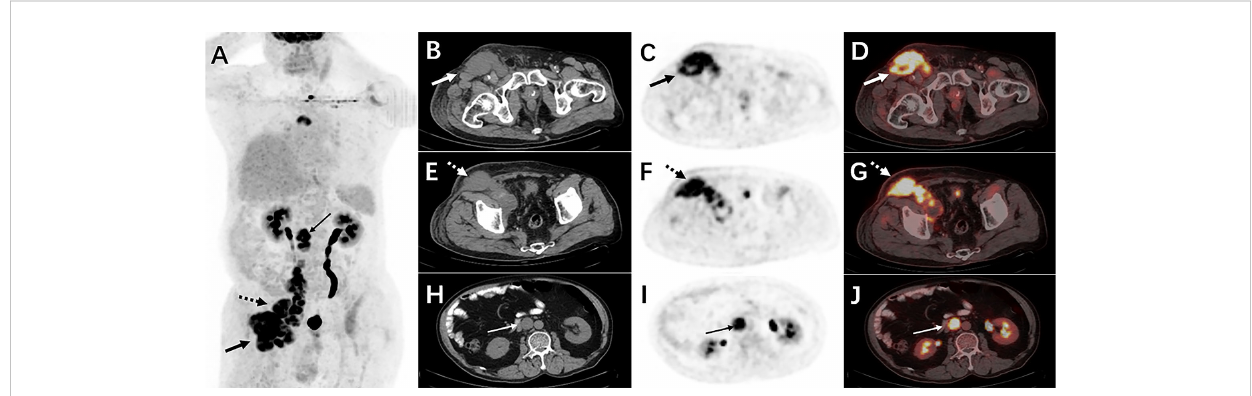
FIGURE 1 The 18 F-FDG PET/CT imaging before treatment. The MIP picture (A) revealed hypermetabolic foci in the retroperitoneum and mediastinum (arrows). On the axial images, several low-density lesions were detected in the right inguinal region (SUVmax 12.1)(solid arrows) ( B : CT, C : PET, D : fusion). The image ( E : CT, F : PET, G : fusion) revealed numerous lymph nodes with abnormal metabolic con fl uence and a SUVmax of 9.8. (dotted arrows). Some retroperitoneal hypermetabolic foci (SUVmax 10.2) were found (thin arrows) ( H : CT, I : PET, J :